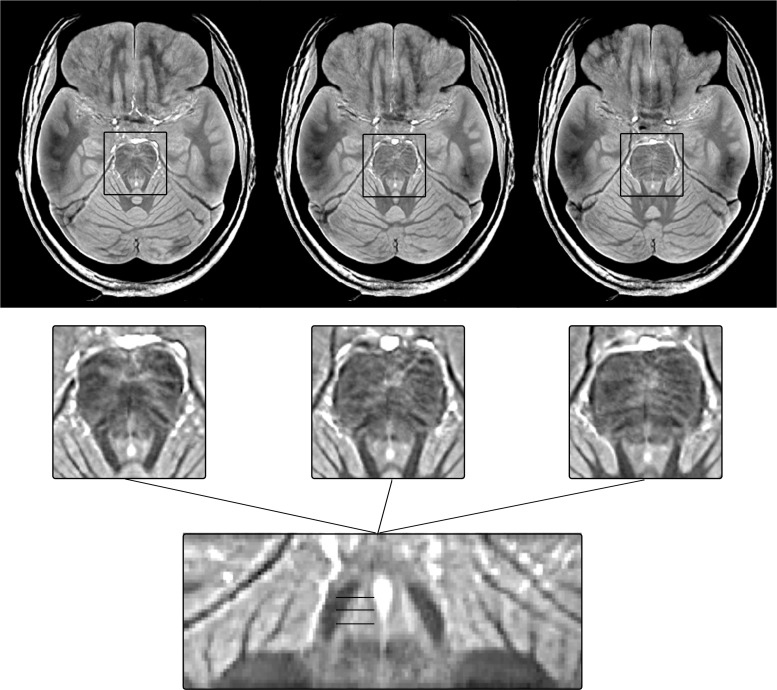
Template of the locus coeruleus for structural analyses.Note: Axial slices of the high-resolution Magnetization-Transfer weighted template (2 mm apart) that was used for structural analysis. Zoomed-in slices at LC level are shown in the middle row. In the last row, a coronal slice of the template is shown at LC level.